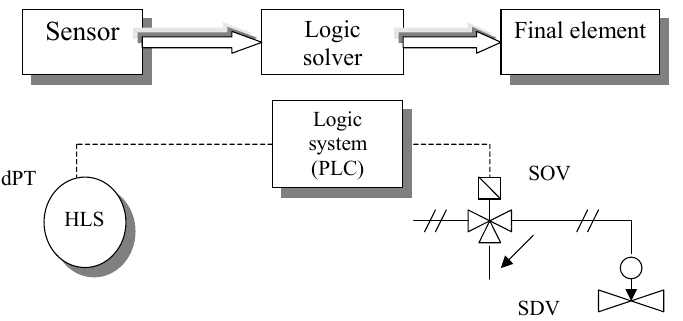
Figure 17. Automatic safety-related loop of E/E/PES. In Figure 17. dPT—the pressure converter; I/I—the transducer, PLC—the pro- grammable logic controller; SOV—the solenoid open valve; SDV—the shutdown valve; HLS—the high-level sensor.